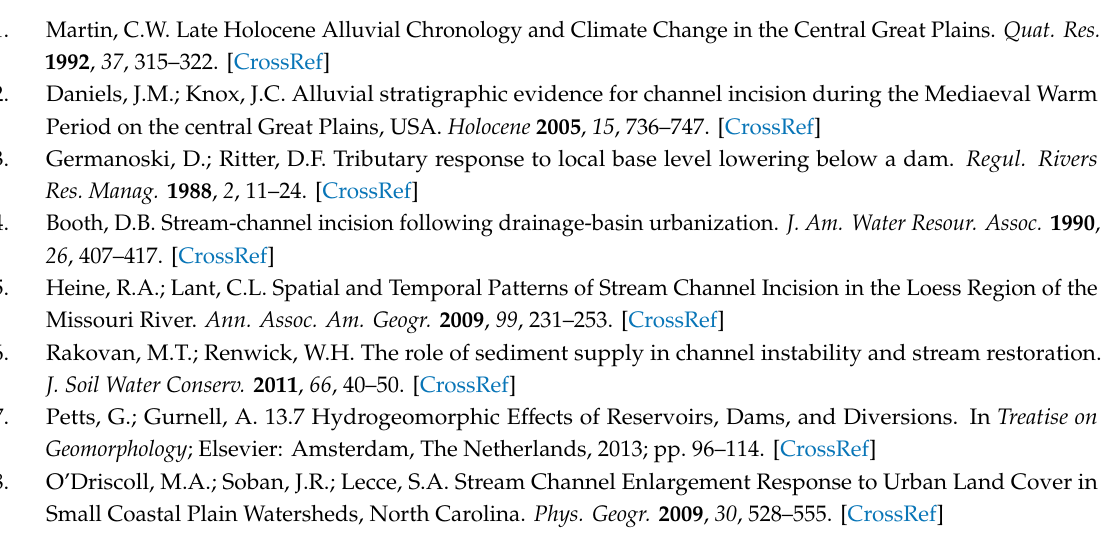
Figure S1: Ten-meter resolution digital elevation model (DEM) map of the Sheyenne grassland, Figure S2: Ten-meter resolution DEM map of the Iron Springs Creek - Drain 10 vicinity, One-meter resolution DEM of the reference and disturbed study-area blocks, Table S1: Water-level data, Table S2: MODFLOW-2005 input files, Table S3: Plant species data and ancillary information, and Table S4: Water-level data retrieved from the North Dakota State Water